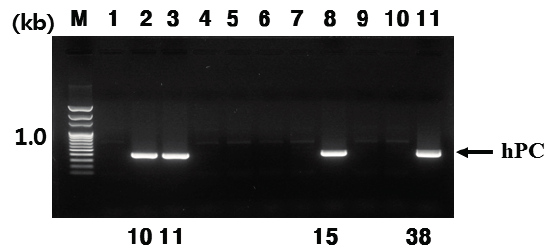
Figure 1. Detection of human protein C (hPC) transgene in founder mice by PCR analysis. Four transgenic mice were identified by transgene specific primers. PCR products are placed on the right. Sizes of DNA markers are on the left (in nucleotides). Lane 1: Negative control with DNA; Lane 2–11: Samples extracted from tails. Number 10, 11, 15, and 38 was detected by PCR as expected size. M: Marker.